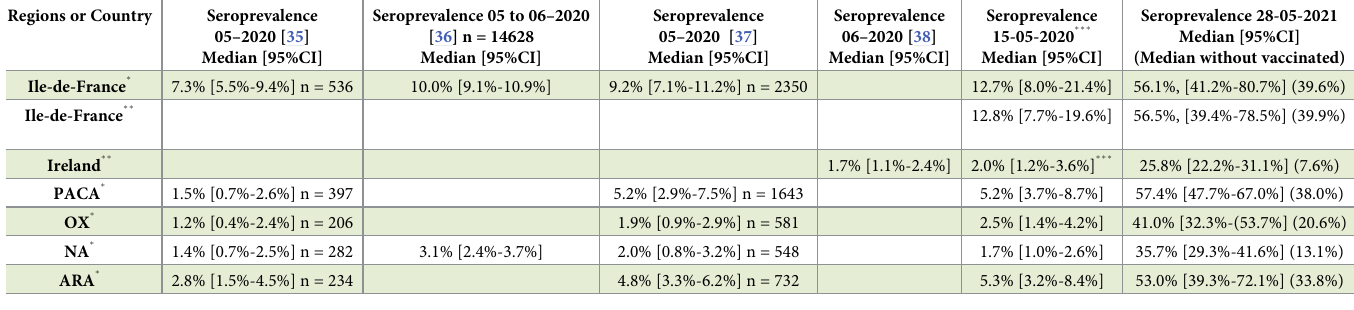
Table 2. Comparison between seroprevalence from different surveys and our seroprevalence estimations for Ile-de-France region, Ireland and four other French regions: Provence Alpes Coˆte d’Azur (PACA), Occitanie (OC), Nouvelle-Aquitaine (NA), Auvergne Rhoˆne Alpes (ARA). For May 2021, we also show our seropreva- lence estimations when “effectively protected vaccinated people” are subtracted from the compartment removed. Regions or Country